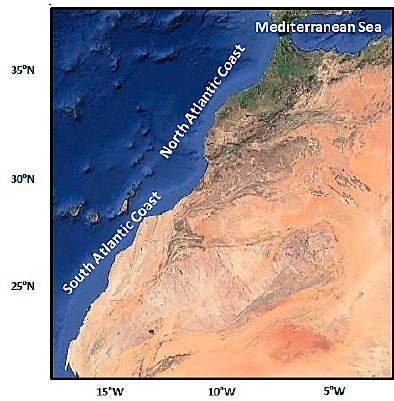
Figure 2. Map of the Moroccan coast with the location of the different regions.